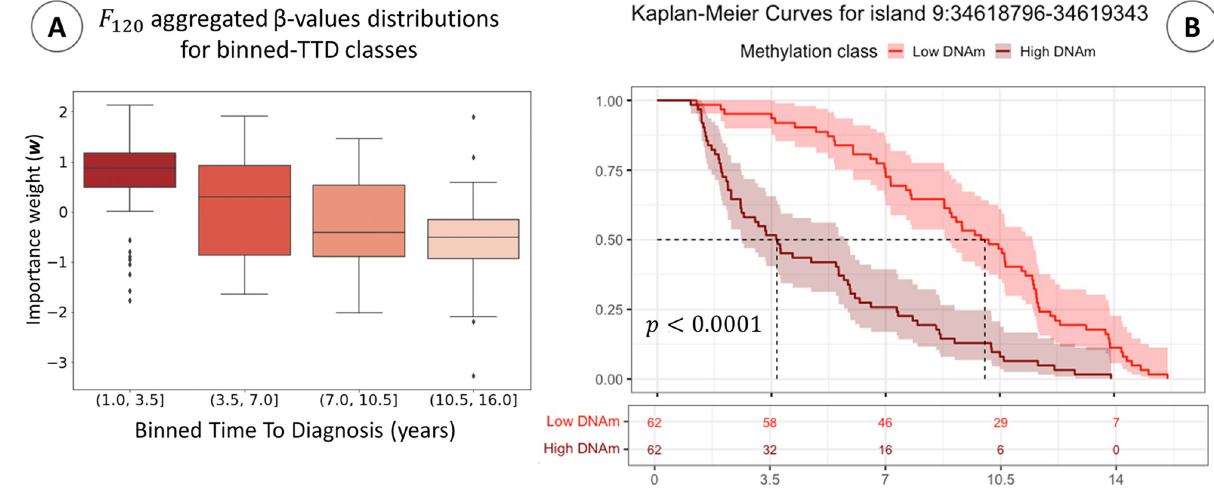
Fig 3. Post-hoc analysis results. (A) Distribution of aggregated DNAm beta-values in the feature ( F 120 ) associated with the highest impact in the estimated effect profile. Subjects are binned according to their TTD into four classes. (B) Kaplan-Meier curves of low DNAm (below 25th percentile of β -values distribution) and High DNAm (above 75th percentile) populations’ in CpG Island 9:34518796–34619343. This island belongs to the cluster that is aggregated into feature F 120 . The plot reports the Log-Rank test p-value for the difference between the two groups; the lower part of the plot reports the count of subjects in High DNAm and Low DNAm populations for CpG Island 9:34518796–34619343, according to TTD.